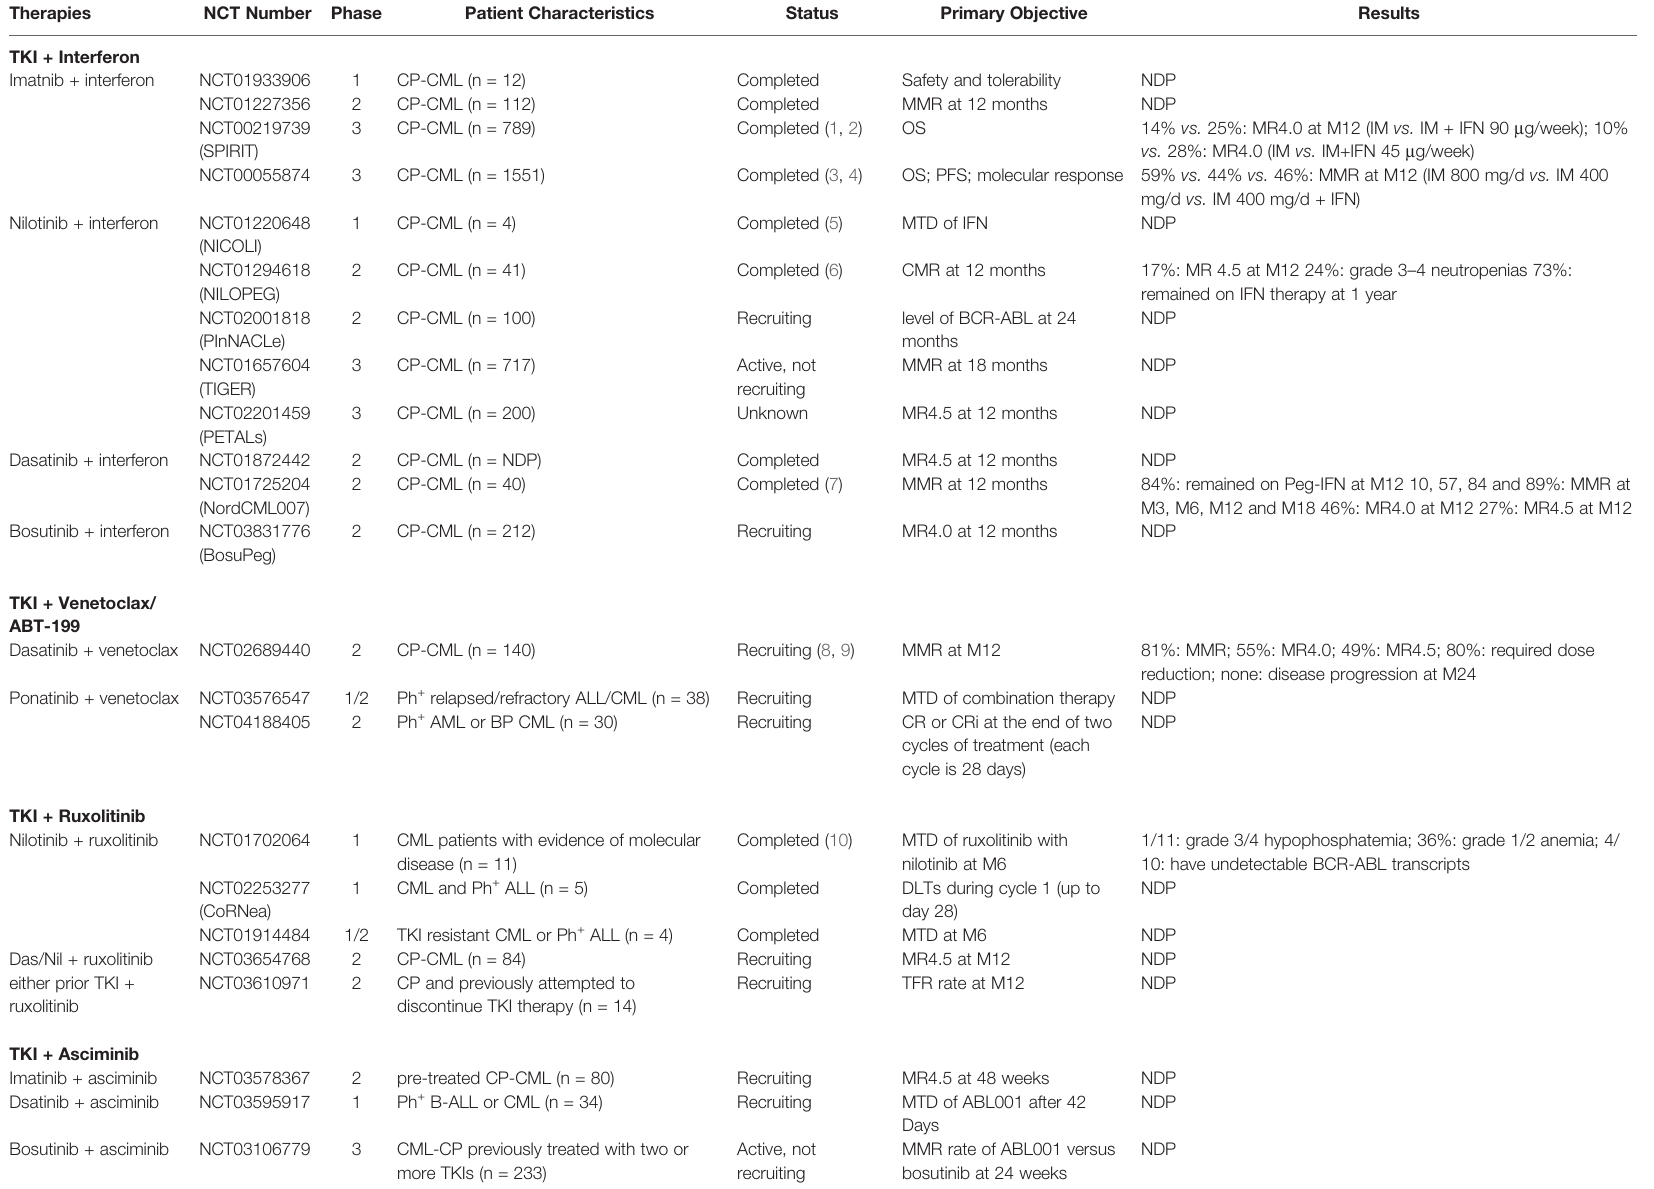
TABLE 1 | Clinical studies of TKI-combined therapies and immune strategies for CML. Therapies